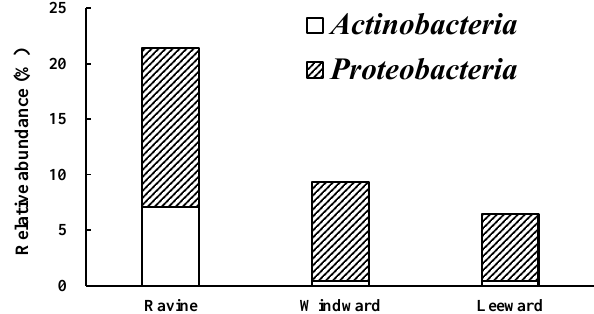
Figure 4. The relative abundance in microbial community of alkB gene lineages. White block indicated the relative abundance of alkB gene in phylum Actinobacteria while the striped block was in Pro-